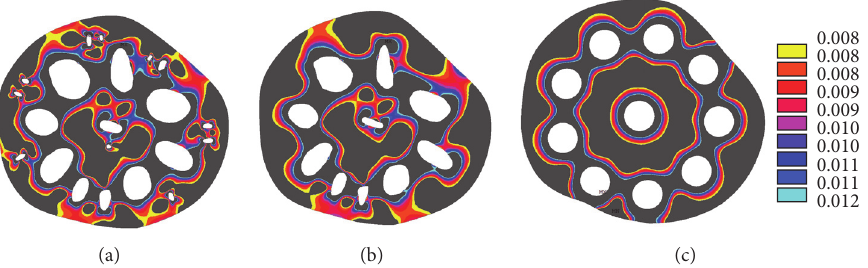
Figure 8: The von Mises stress (MPa) in the cross-sectional area of lotus root (a) with small holes, (b) no small holes, and (c) with circular holes.